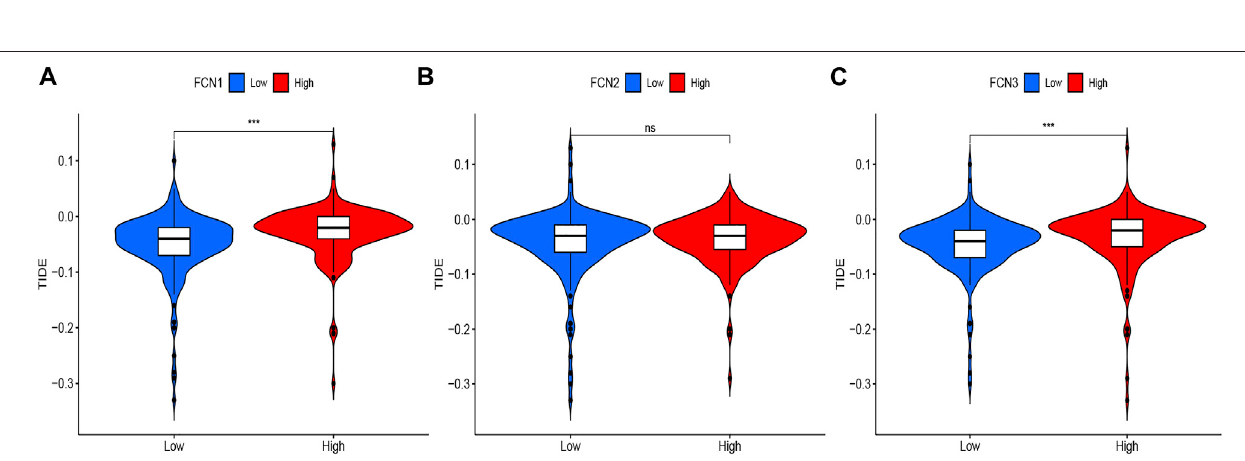
Frontiers in Genetics |